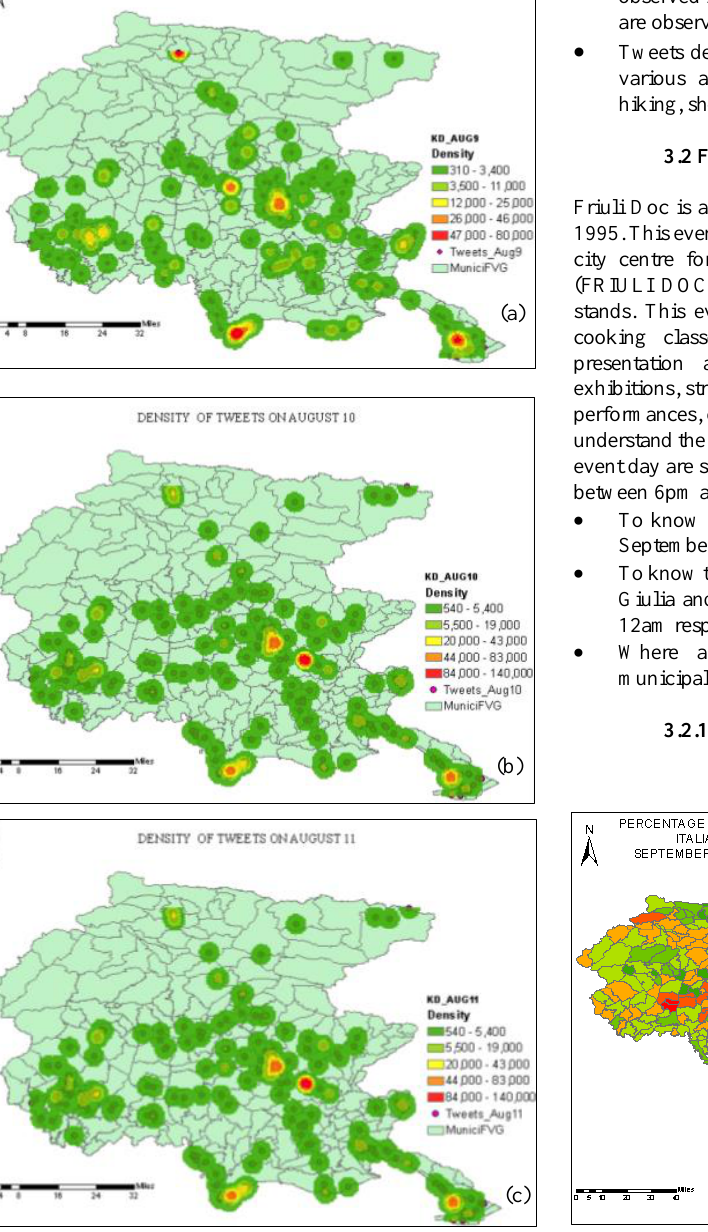
Figure 3.1.4-5 a, b, c Tweet Density on August 9, 10, 11  Red color represent maximum tweet density and mostly related tweets in that place. Green - very less tweets and unrelated tweets. Yellow – tweets which are likely related to our scenario (Grado beach)